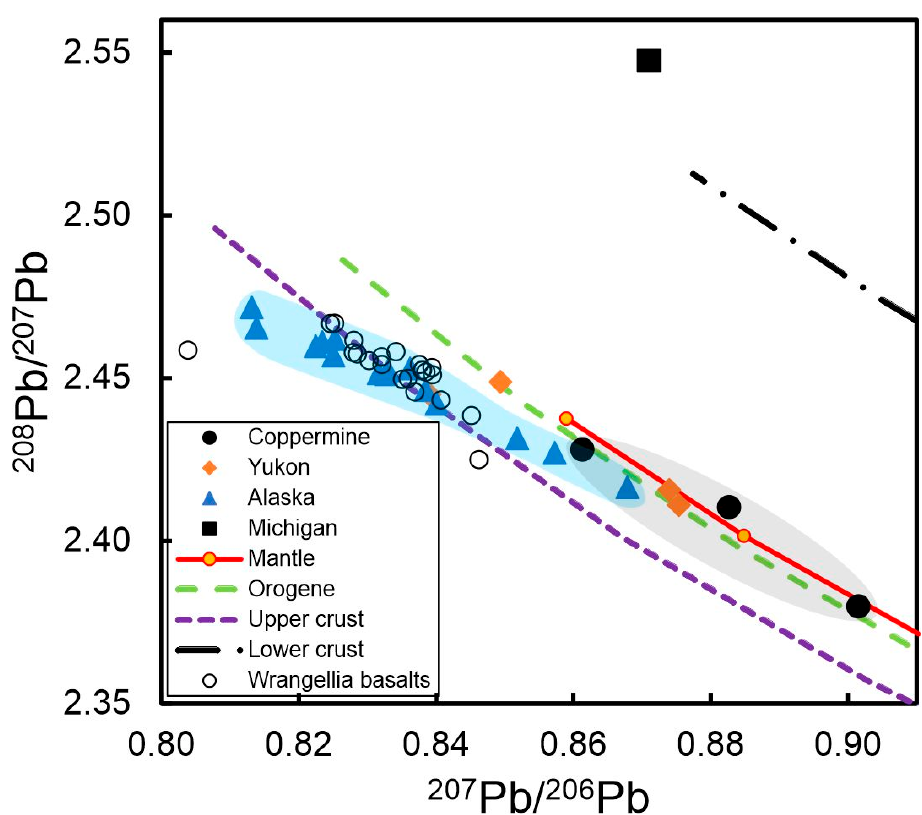
Figure 4. Plot illustrating 208 Pb/ 207 Pb versus 207 Pb/ 206 Pb ratios for native Cu samples investigated here. Pb isotope data for mantle, orogene, and lower and upper crust evolution curves are taken from [28], whereas Pb isotope compositions for Wrangellia basalts are from [29]. Blue field denotes range of compositions for Alaskan native Cu samples; gray field outlines range of compositions for samples from Coppermine region. Error bars are within the size of the symbol.